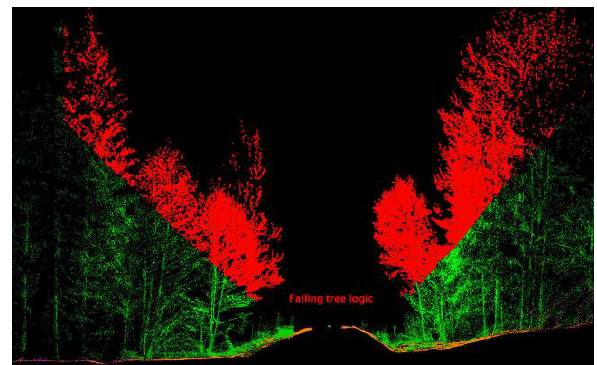
Figure 19: Checking the tree-fall hazard around a rail track in Sweden using TerraScan